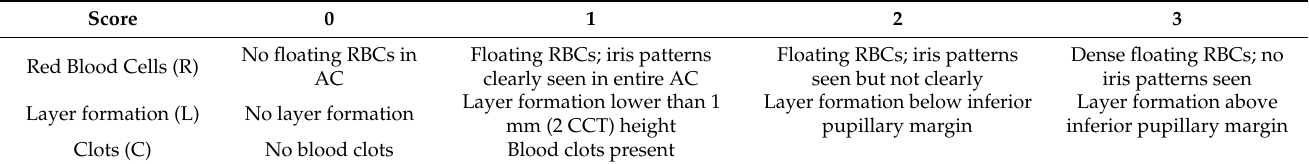
Table 1. Shimane University RLC postoperative hyphema scoring